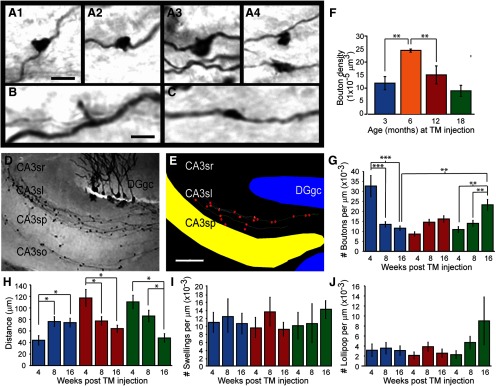
Spatiotemporal maturation of adult-born GC mossy fiber axon terminals in adult and aged mice. A, Examples of large complex MFBs labeled by immunohistochemistry with an antibody against GFP. B, Example of a lollipop bouton. Note short thin collateral and small bulbous terminal. C, Example of an immunolabeled en passant swelling in newborn mossy fiber axon. Note the small diameter of the swelling and that it is in line with the axon. D, Low-power image of immunolabeled adult-born mossy fibers and boutons in region CA3. E, Neurolucida reconstructions of adult-born mossy fibers and boutons taken from image in D. F, Spatial density of labeled MFBs in stratum lucidum at 8W post-TM administration in adult (3 M; n = 400), midlife (6 M; n = 252), and aged (12 M and 15 M; n = 249 and n = 261, respectively) animals. G, Axonal density measures of MFBs at various times post-TM administration in adult and aged animals (3 M: n = 135, 12 M: n = 146, 18 M: n = 128). H, Interbouton spacing measures of MFBs at various times post-TM administration in adult and aged animals (3 M: n = 135, 12 M: n = 146, 18 M: n = 128). I, Axonal density measures of en passant swellings at various times post-TM administration in adult and aged animals (3 M: n = 110, 12 M: n = 116, 18 M: n = 90). J, Axonal density measures of mossy fiber lollipop boutons at various times post-TM administration in adult and aged animals (3 M: n = 25, 12 M: n = 30, 18 M: n = 38). CA3, cornu ammons region 3; DGgc, dentate gyrus GCL; sr, stratum radiatum; sl, stratum lucidum; sp, stratum pyramidale; so, stratum oriens. Scale bars = 5 μm (A), 10 μm (B, C), 500 μm (E); *p < 0.05, **p < 0.01, ***p < 0.005, two-way ANOVA followed by Student’s t test. All values are mean ± SEM.